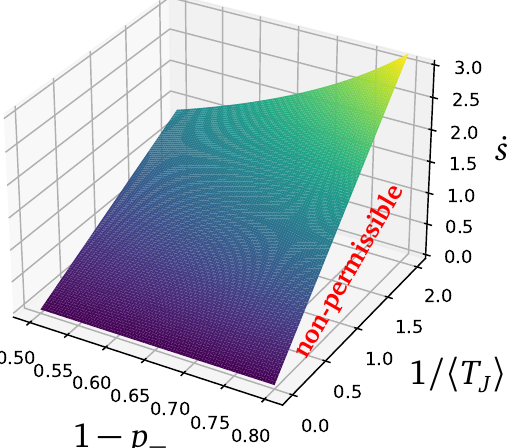
Figure 2: Universal tradeoff between speed, uncertainty, and dissipation in nonequi- librium processes